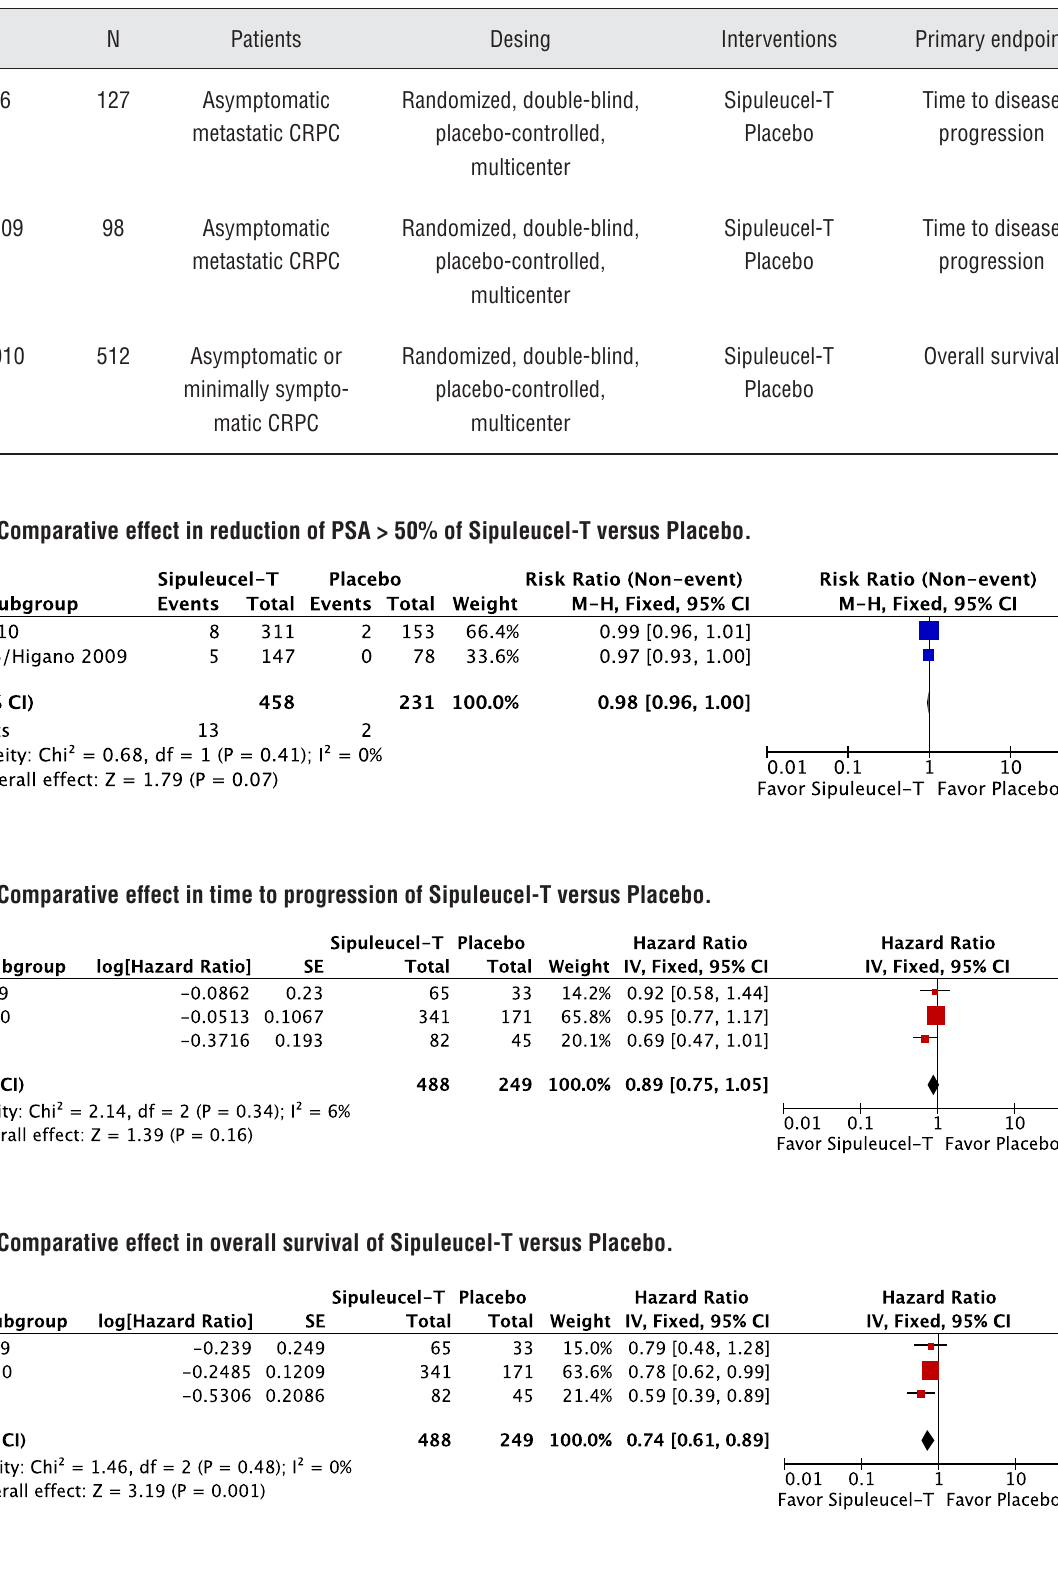
Table 2 - Characteristics of Included Studies.